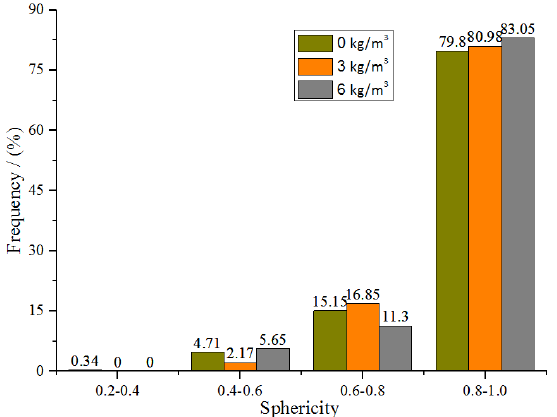
Figure 7. Distribution of sphericity.